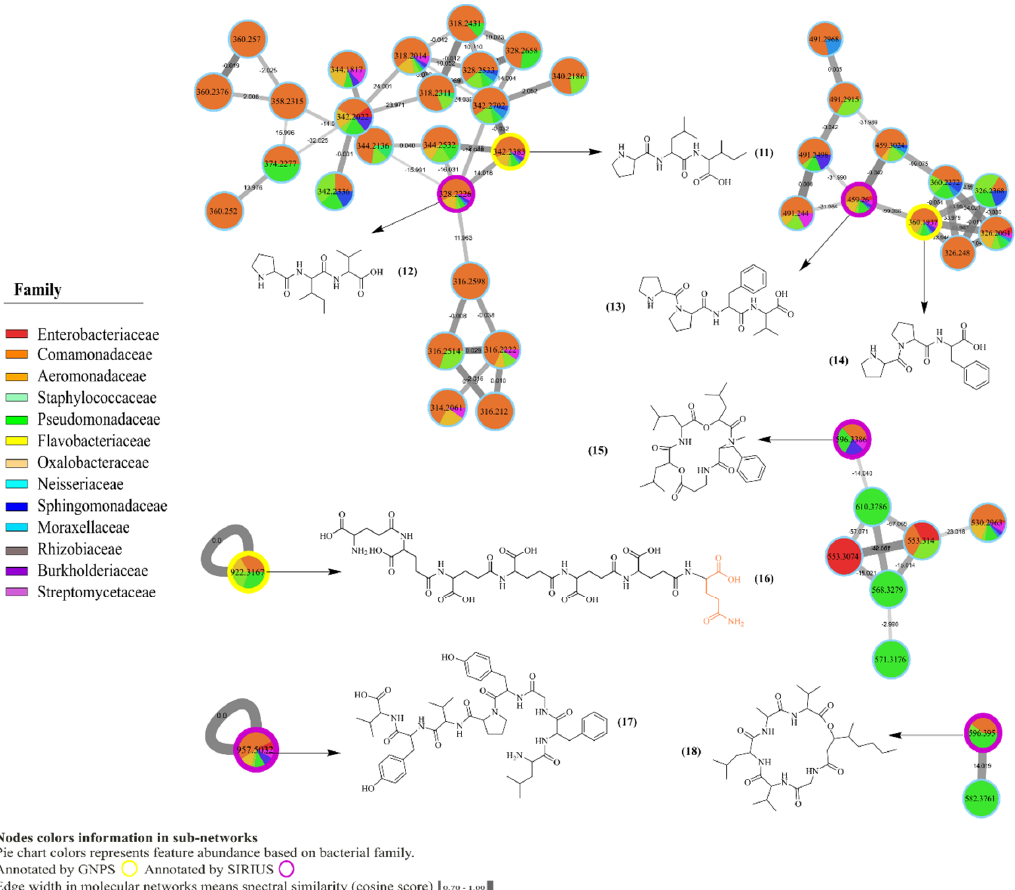
Figure 3. Molecular network of annotated peptides identified in crude extracts of bacterial isolates from skin of C. panamansis by LC-MS/MS analysis. Highlighted nodes correspond to annotated metabolites by GNPS (yellow) and SIRIUS CSIFingerID (purple). Pie charts inside nodes denotes abundance while colors correspond to the bacterial family where the feature was found. Edge width between nodes displays cosine score values, which are related to the spectral similarities between nodes.